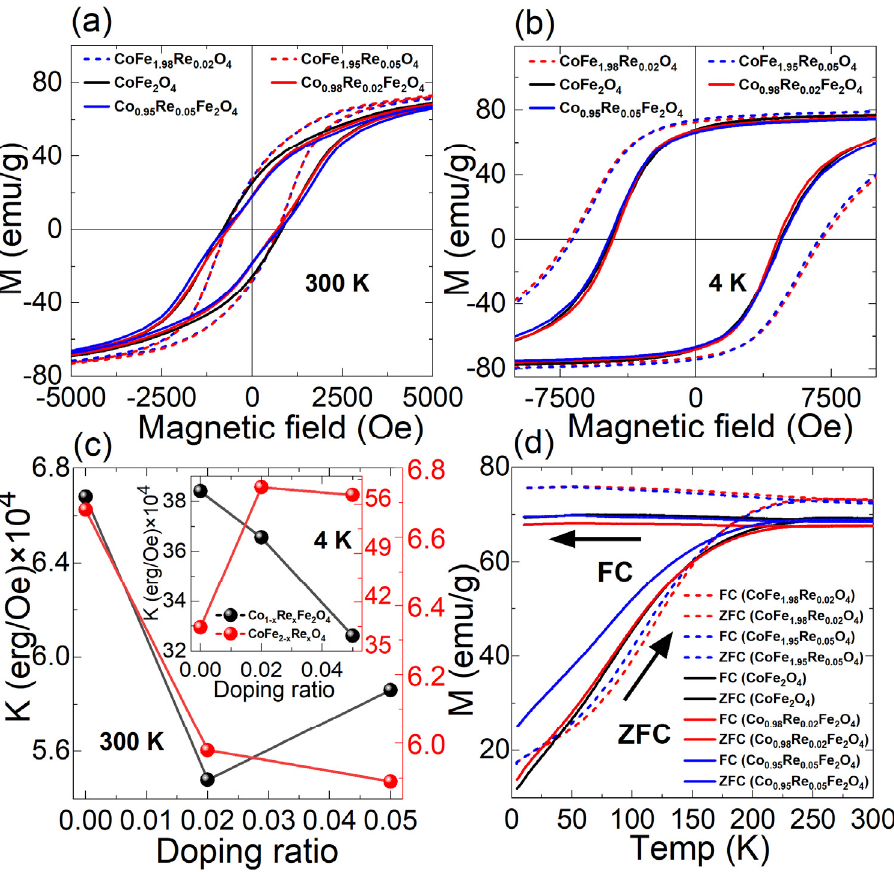
Figure 6. Magnetic hysteresis loops of Co 1-x Re x Fe 2 O 4 and CoFe 2-x Re x O 4 nanoparticles at ( a ) 300 K and ( b ) 4 K, showing a variation in the hysteresis shape with different sites of doping. ( c ) Variation in anisotropy at 300 K and 4 K with respect to the doping ratio. The anisotropy decreases for Co-site doping, while it increases for Fe-site doping. ( d ) M-T curve of Co 1 − x Re x Fe 2 O 4 and CoFe 2 − x Re x O 4 nanoparticles, indicating a spin-glass-like behavior of the nanoparticles. Table 2. Magnetic parameters ( M s , M r , M r / M s , H c , and K ) of Re-doped nanoparticles were extracted at 300 K and 4 K. With the increased Re doping ratio, the magnetic parameters reduced in Co-site doping, while they were enhanced in Fe-site doping.